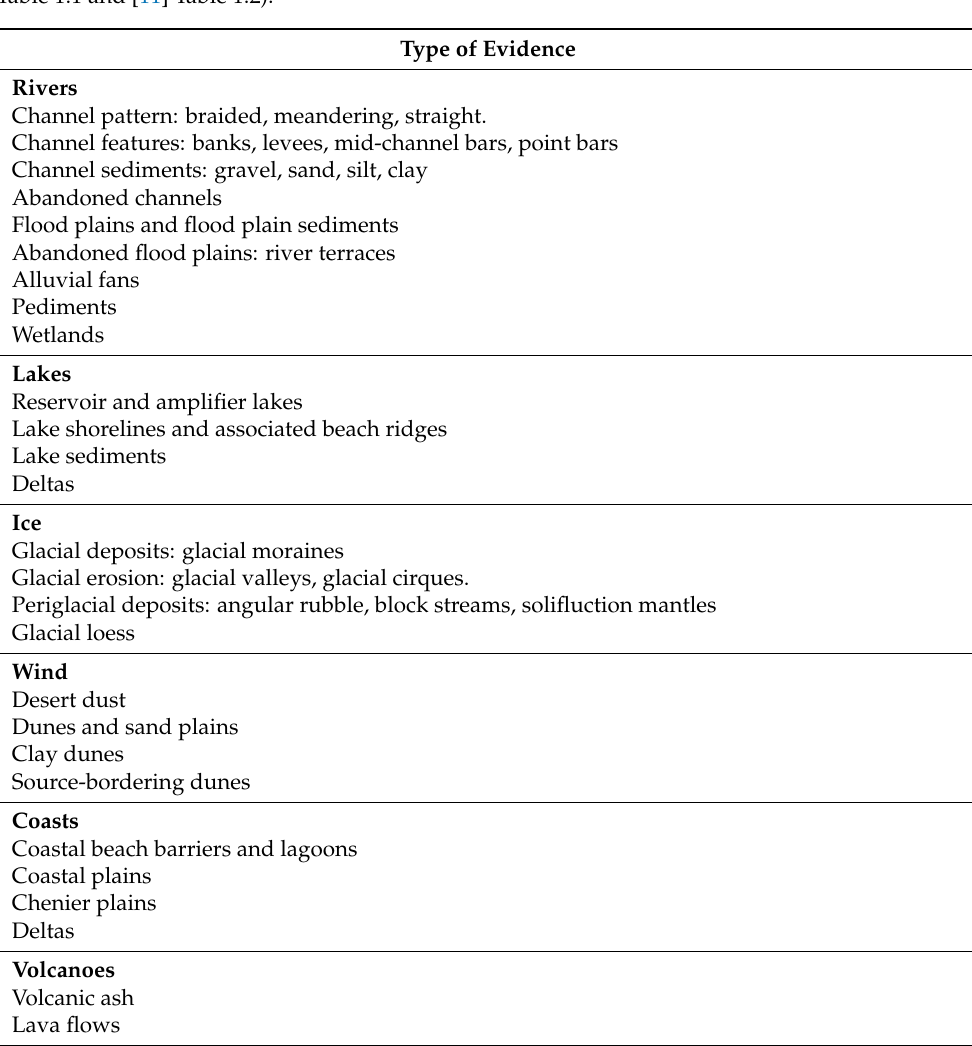
Table 1. Geomorphological evidence used to reconstruct prehistoric environments. (Adapted from [9] Table 1.1 and [11] Table